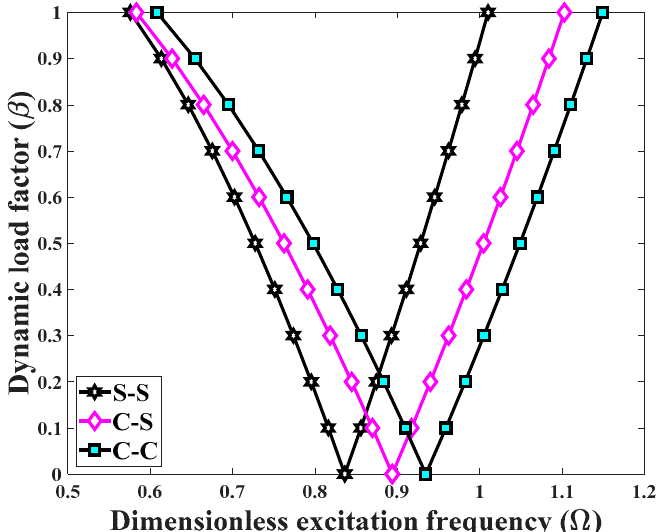
Figure 6. Effect of boundary conditions on the DIR for a BD-FG cylindrical shell with Figure 6. E ff ect of boundary conditions on the DIR for a BD-FG cylindrical shell with R = 0.5 m, h / R = 0.02, L / R = 1, n x = n z = 1, α =